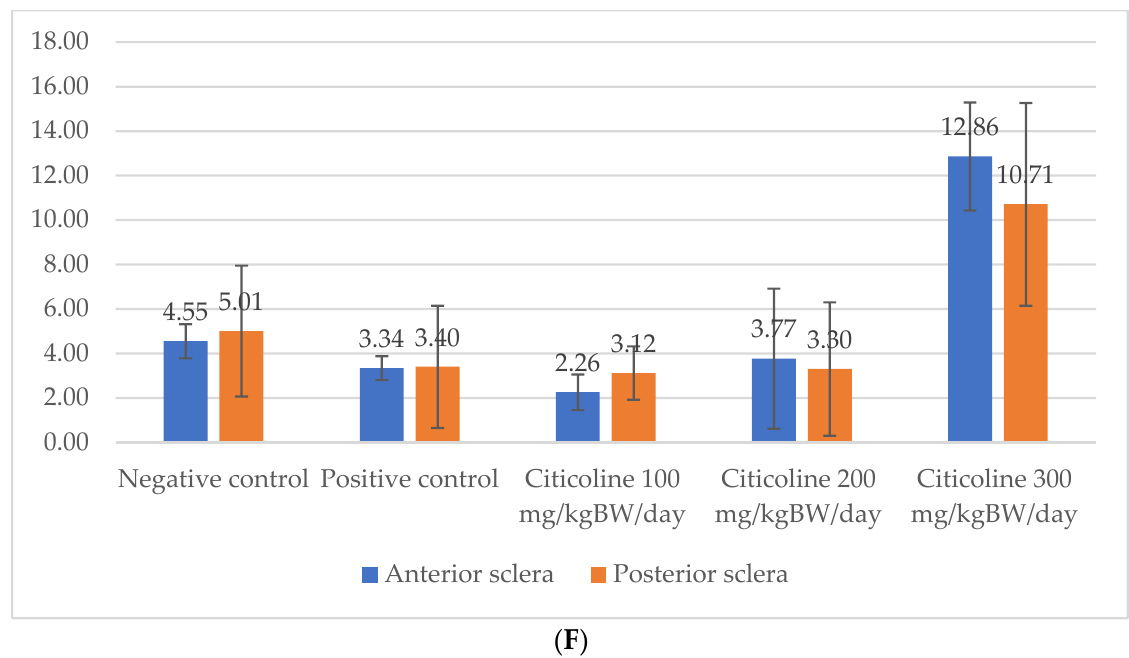
Figure 5. The Rats’ Scleral Tissue after Antibody Anti-TGF- β 1 Staining (Upper) ( A – E ). ( A ) The negative control group; ( B ) the positive control group; ( C ) the treatment groups administered with a citicoline dosage of 100 mg/kg BW; ( D ) 200 mg/kg BW; ( E ) 300 mg/kg BW. ( F ) A chart illustrating the mean TGF- β 1 expressions in the anterior and posterior scleral tissue (Lower). From Tukey test, we found that the treatment group administered with 300 mg/BW/day has the highest TGF- β 1 expression compared to the negative control group (12.86 ± 2.43 vs. 4.55 ± 0.77, p = 0.000 in the anterior sclera and 10.71 ± 4.56 vs. 5.01 ± 2.94, p = 0.042 in the posterior sclera), the positive control group (12.86 ± 2.43 vs. 3.34 ± 0.54, p = 0.000 in the anterior sclera and 10.71 ± 4.56 vs. 3.40 ± 1.75, p = 0.006 in the posterior sclera), the treatment group administered with 100 mg/BW/day (12.86 ± 2.43 vs. 2.26 ± 0.80, p = 0.000 in the anterior sclera and 10.71 ± 4.56 vs. 3.12 ± 1.20, p = 0.005 in the posterior sclera), and the treatment group administered 200 mg/BW/day (12.86 ± 2.43 vs. 3.77 ± 3.15, p = 0.000 in the anterior sclera and 10.71 ± 4.56 vs. 3.30 ± 3.00, p = 0.006 in the posterior sclera).